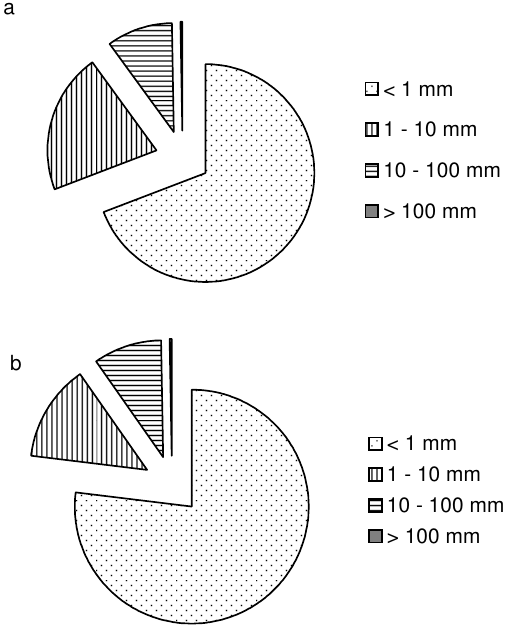
Fig. 5. Percent frequency of daily rainfall in Genoa (a) and Chiavari (b) .